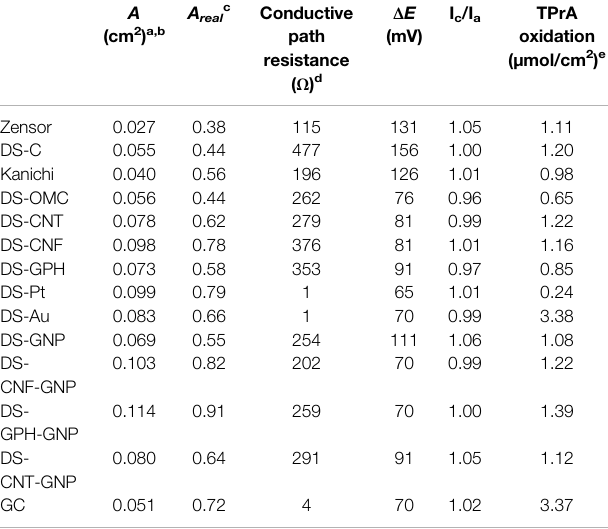
TABLE 1 | Electrochemical properties of various commercially available SPEs.